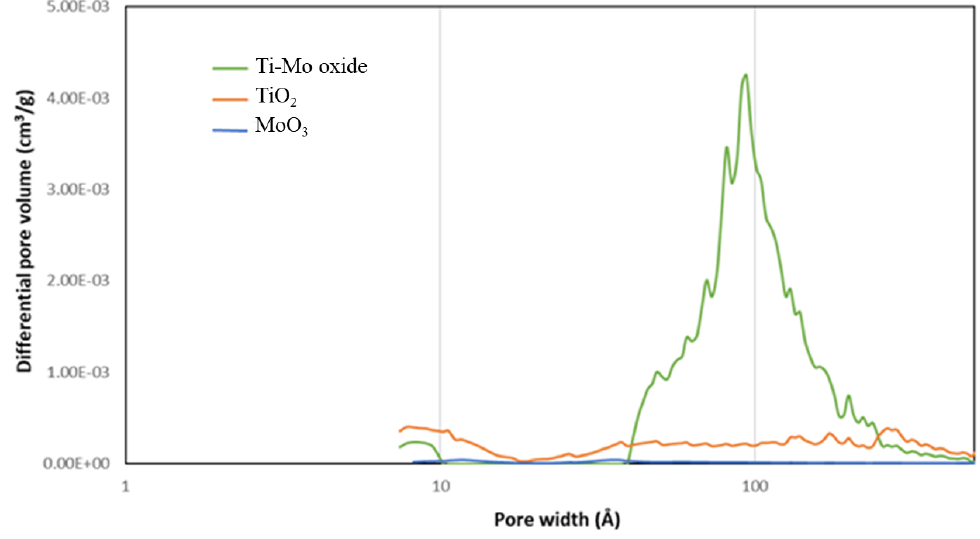
Figure 7. Pore size distribution of the as-prepared metal oxide samples. Table 1. Surface Structural